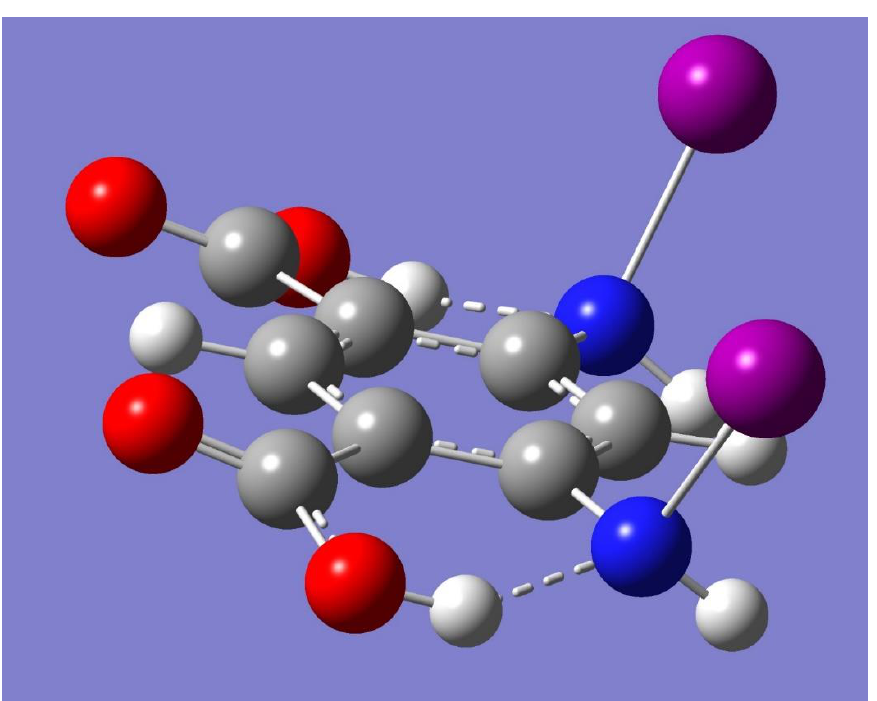
Figure 1. Optimized geometry of the molecular model system, ((HOOC) 2 -C 6 H 2 -(NHI) 2 ). Intramolec- ular OH…N hydrogen bonding indicated with dashed lines. Individual atoms can be distinguished by color: C (grey), H (white), N (blue), O (red), and I (purple).